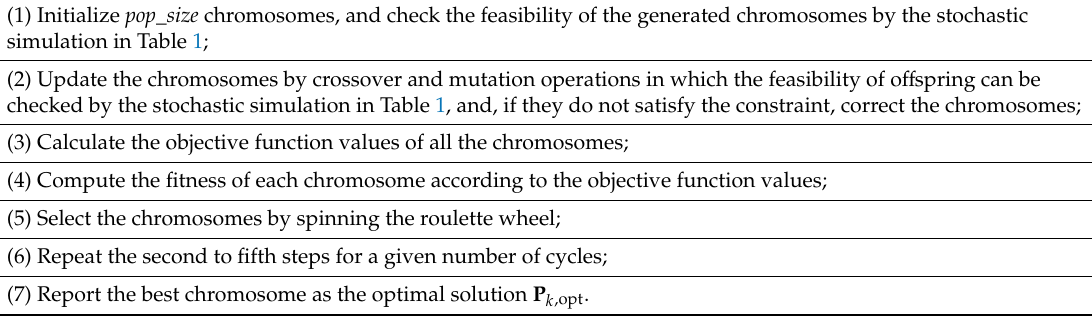
Table 2. The hybrid intelligent optimization